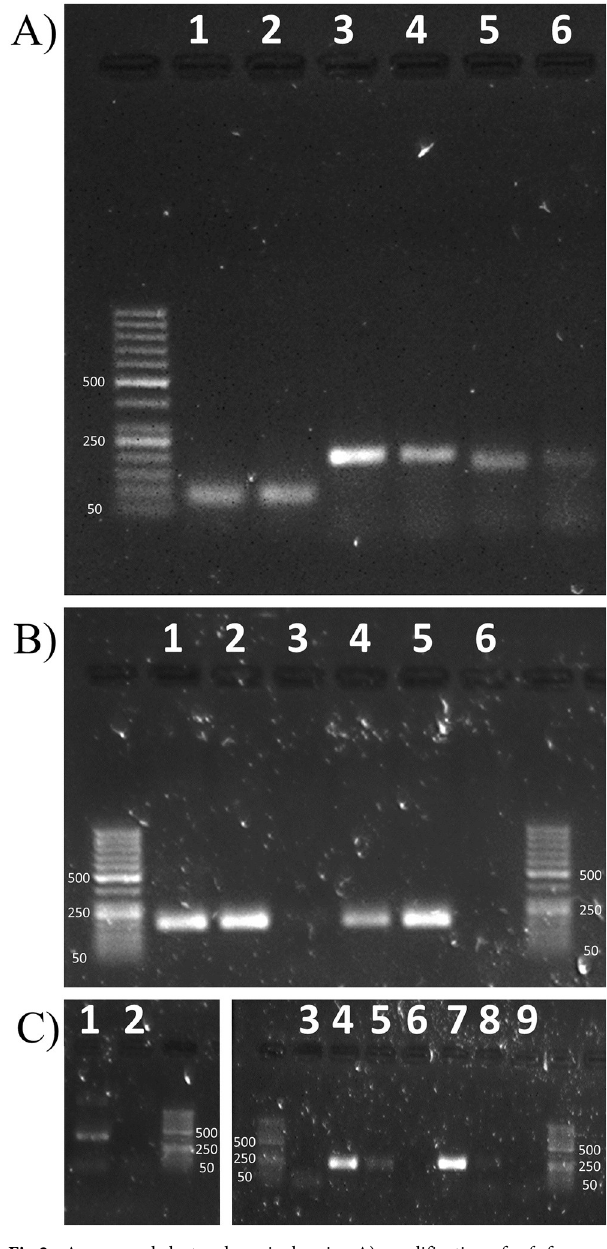
Fig 2. Agarose gel electrophoresis showing A) amplification of egfp from genetically modified fruit fly ( Drosophila melanogaster )– 1: fly tissue with egfp_F1/R1, 2: fly food media with egfp_F1/R1, 3: fly tissue with egfp_F2/R2, 4: fly food media with egfp_F2/R2, 5: fly tissue with egfp_F3/R3, 6: fly food media with egfp_F3/R3, B) amplification of tdTomato from feces, urine, and saliva of genetically modified mouse ( Mus musculus )– 1,2: mouse feces from different cages, 3: mouse urine (weak amplification), 4: mouse mouth swab, 5: mouse ear punch, 6: DNA extraction negative control (no amplification), and C) amplification of dsRed2 , ZsGreen1 , and ZsYellow1 from filtered aquarium water of GloFish 1 tetras ( Gymnocorymbus ternetzi )– 1: 0.22 μ M filtered water with dsRed2 F1/R1, 2: 0.7 μ M filtered water with dsRed2 F1/R1 (no amplification), 3: DNA extraction negative control (no amplification), 4: 0.22 μ M filtered water with ZsGreen1 F1/R1, 5: 0.7 μ M filtered water with ZsGreen1 F1/R1 (weak amplification, 6: DNA extraction negative control (no amplification), 7: 0.22 μ M filtered water with ZsYellow1 F1/R1, 8: 0.7 μ M filtered water with ZsYellow1 F1/ R1 (weak amplification), 9: DNA extraction negative controls (no amplification). Gel images were captured using Quantum Vilber Lourmat (MBI) and were cropped to only relevant lanes.